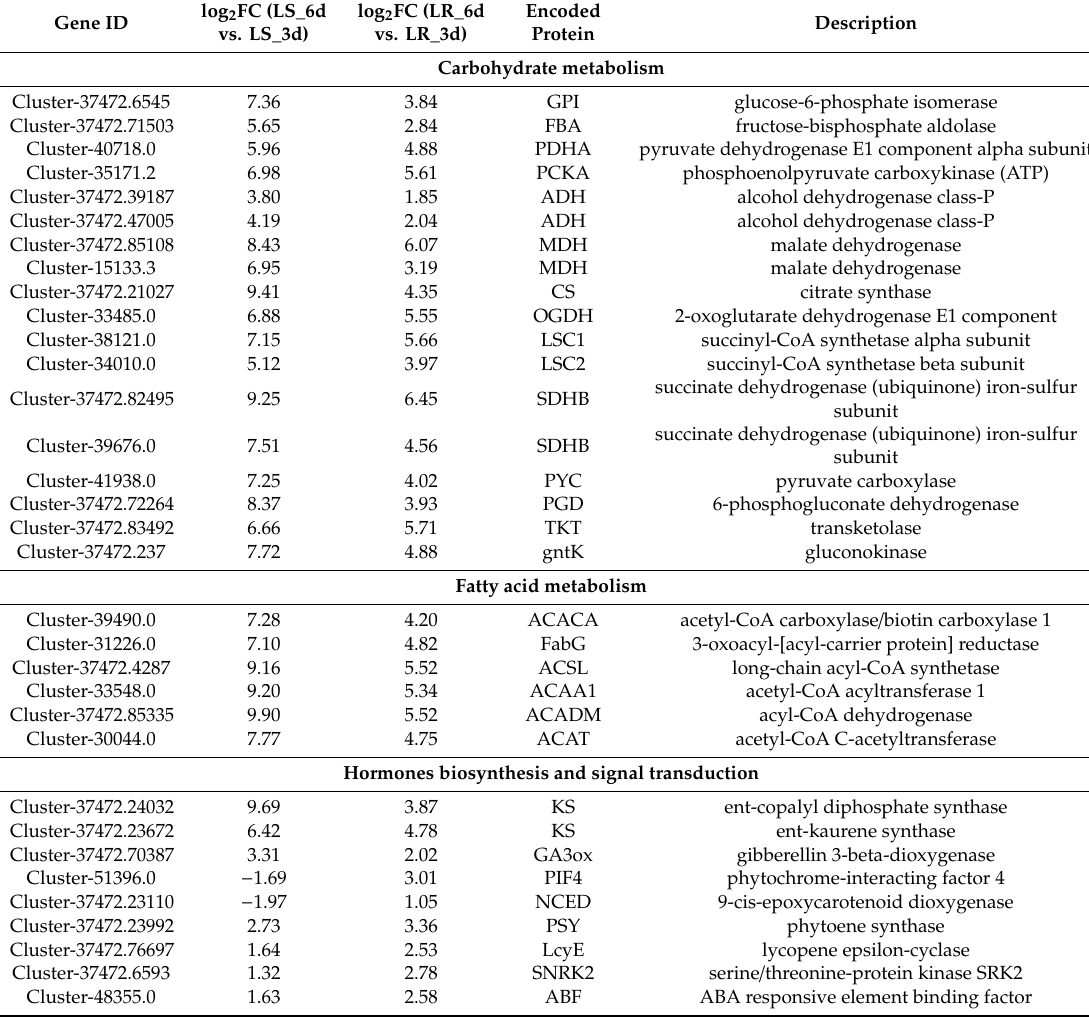
Table 1. DEGs significantly up- or downregulated in LS and LR comparison settings. Gene